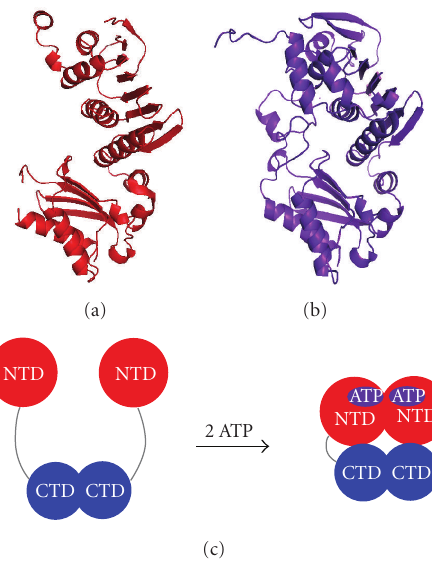
Figure 8: Crystal structures of the apo form ((a) PDB ID: 1BKN) and ADPNP-bound form ((b) PDB ID: 1B63) of the E. coli MutL N-terminal domain. (c) A schematic representation of a model for the ATP-dependent conformational change of full-length MutL α [73]. NTD and CTD indicate the N-terminal ATPase domain and the C-terminal endonuclease domain, respectively. In the apo form of MutL α , the PMS2 and MLH1 subunits dimerize via their C- terminal domains. ATP binding induces the dimerization of the N- terminal domain and condensation of the